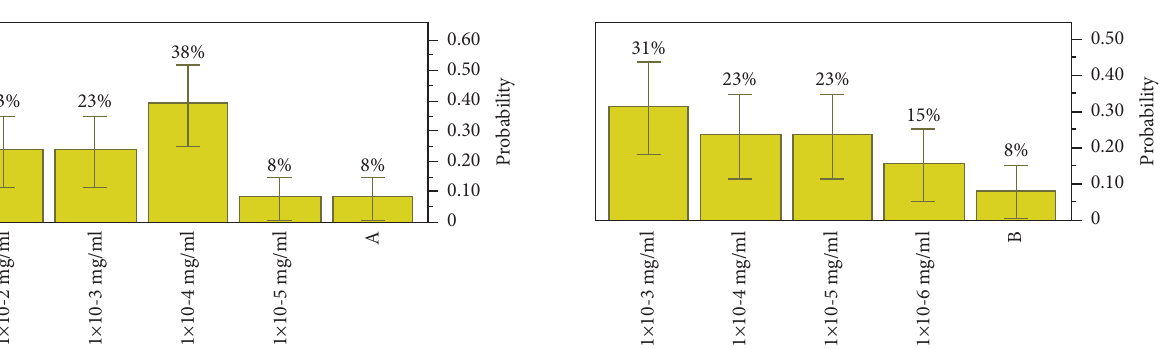
Figure 1: Distributions and test probabilities of extract A on target organisms.